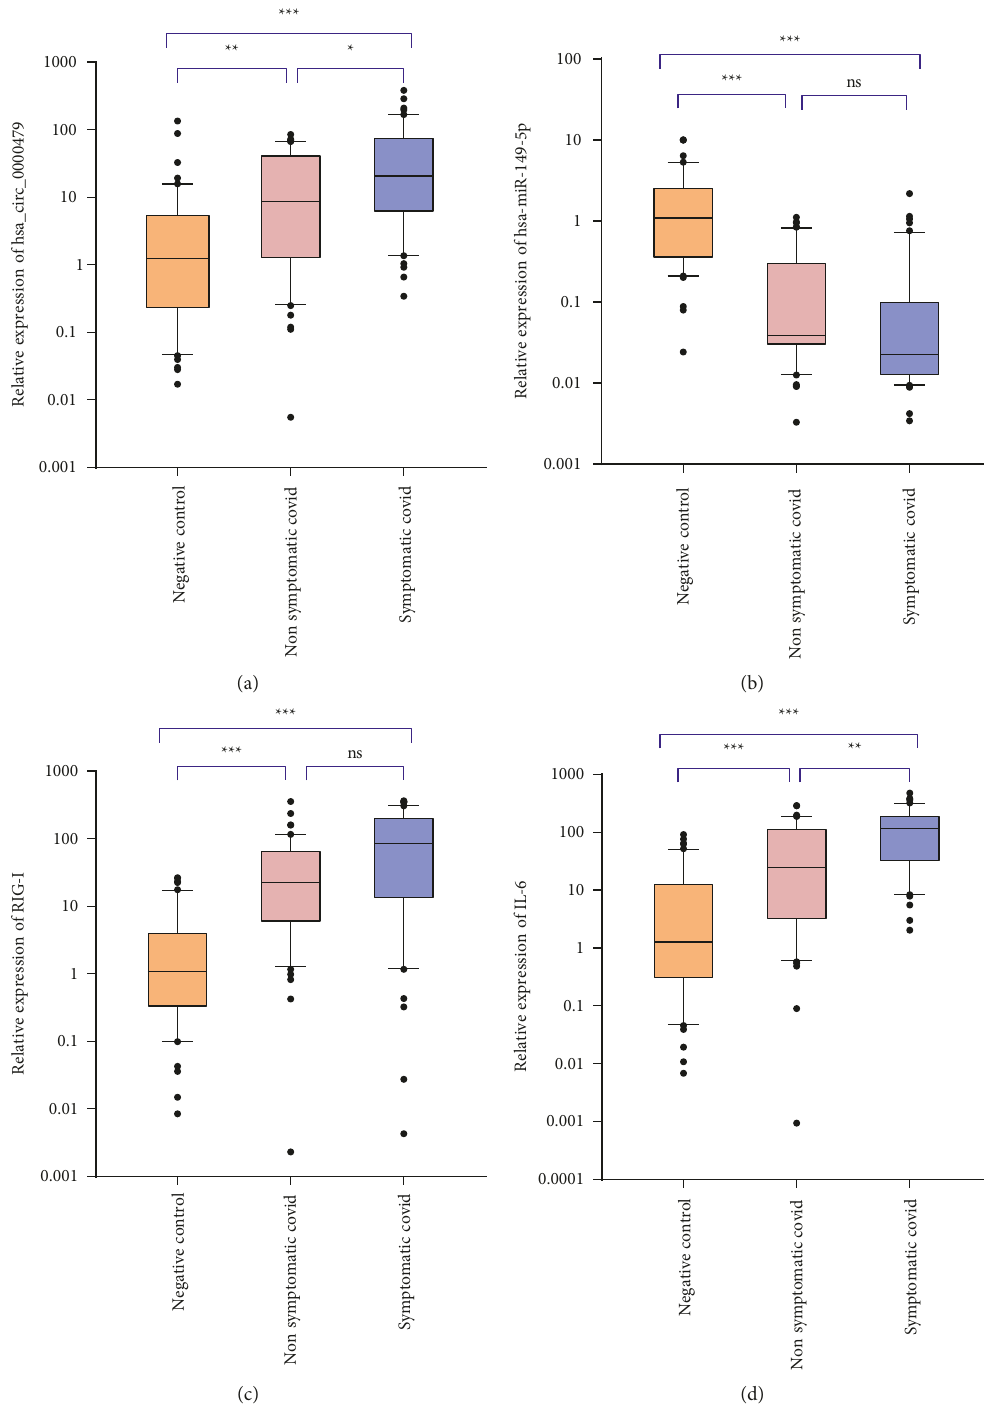
Figure 1: The box and whisker plot (10–90 percentile) of the relative expression levels of hsa_circ_0000479, hsa-miR-149-5p, IL-6, and RIG- I (ns: P > 0 . 05 ∗ P ≤ 0 . 05; ∗∗ P ≤ 0 . 01; ∗∗∗ P < 0 . 001). (a) Upregulation of hsa_circ_0000479 in COVID-19 patients compared to healthy. (b) Down expression of hsa-miR-149-5p in COVID-19 patients compared to healthy controls. (c) Upregulation of RIG-I in COVID-19 patients compared to healthy controls. (d) Upregulation of IL-6 in COVID-19 patients compared to healthy